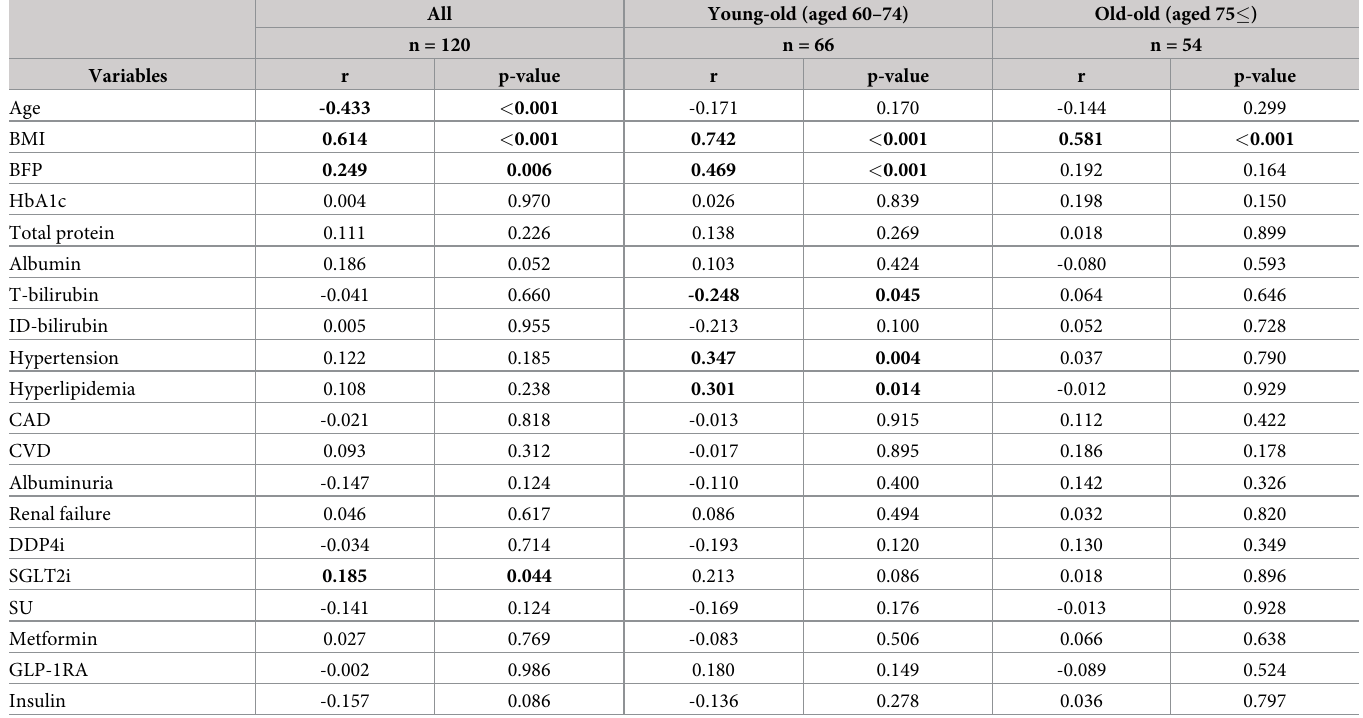
Table 3. Univariate analysis of factors associated with skeletal muscle mass index (SMI) in